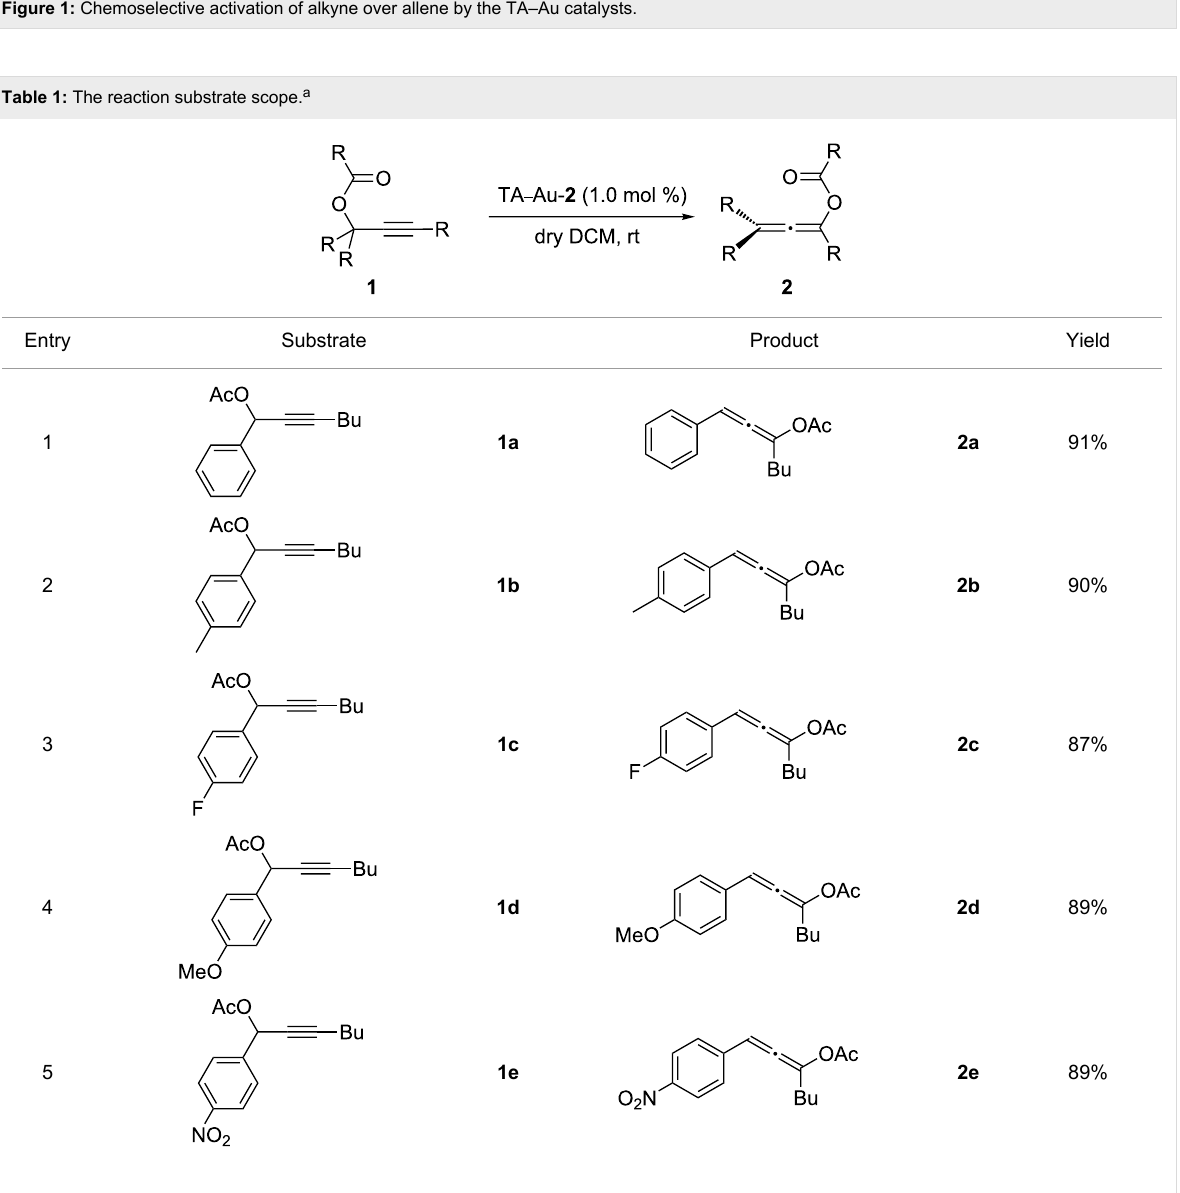
Table 1: The reaction substrate scope.